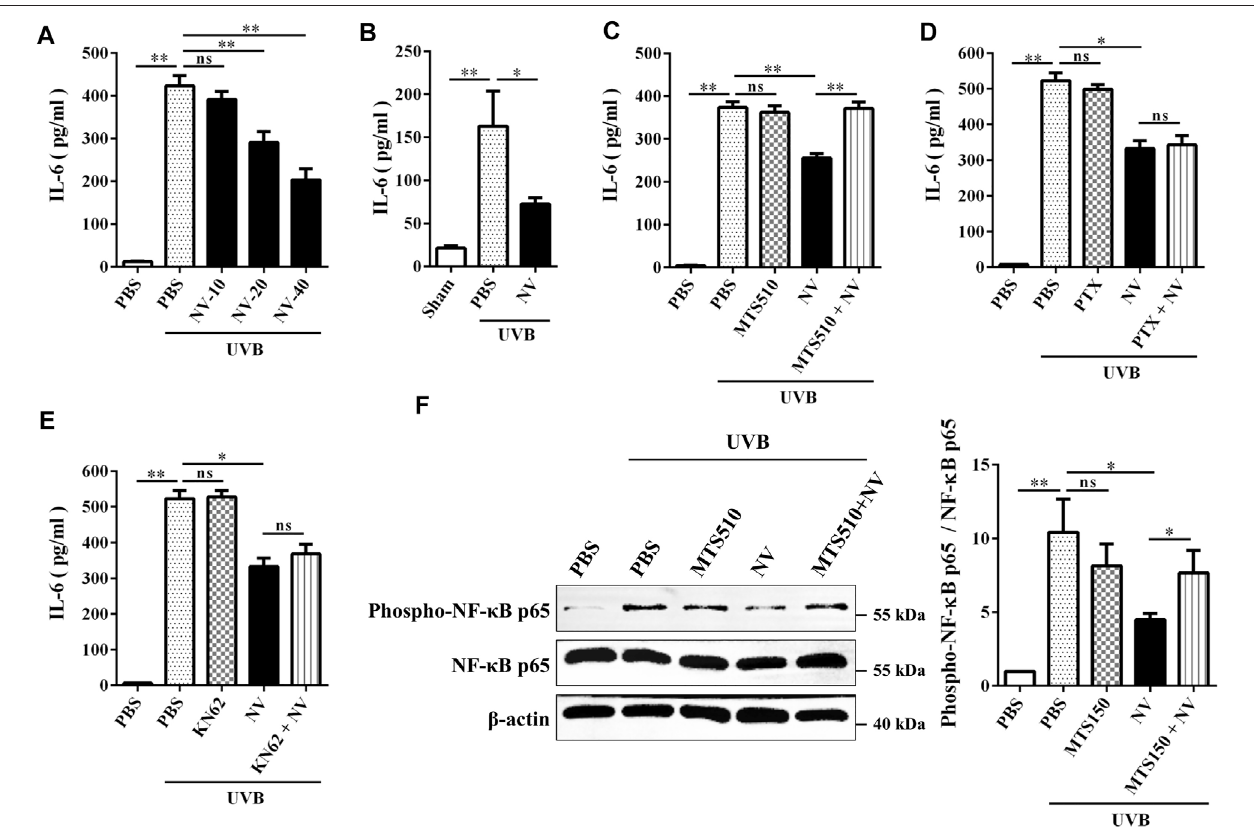
FIGURE7| Antioxidin-NVinhibited UVB-induced IL-6expressionbyinhibitingtoll-likereceptor 4(TLR4). (A , B) Antioxidin-NV signi fi cantlydecreasedIL-6secretion in UVB exposed HaCaT cells (A) and UVB exposed hairless mice skin (B) . (C – E) Toll-like receptor (TLR) 4 mediate the antioxidin-NV-induced IL-6 down-regulation. MTS510,toll-likereceptor(TLR)4inhibitor;KN-62,thepurinereceptorinhibitor;PTX,Gproteincouplingreceptorinhibitor. (F) Westernblotshowedeffectsofantioxidin- NV on P65 protein kinases phosopholyation in HaCaT cells and relative activation analysis. Data are presented as mean ± SD ( n (cid:1) 3). NV-10, 20, 40 indicated the concentrations of 10, 20, 40 μ g/ml respectively. ns, no signi fi cance, * p < 0.05, ** p <